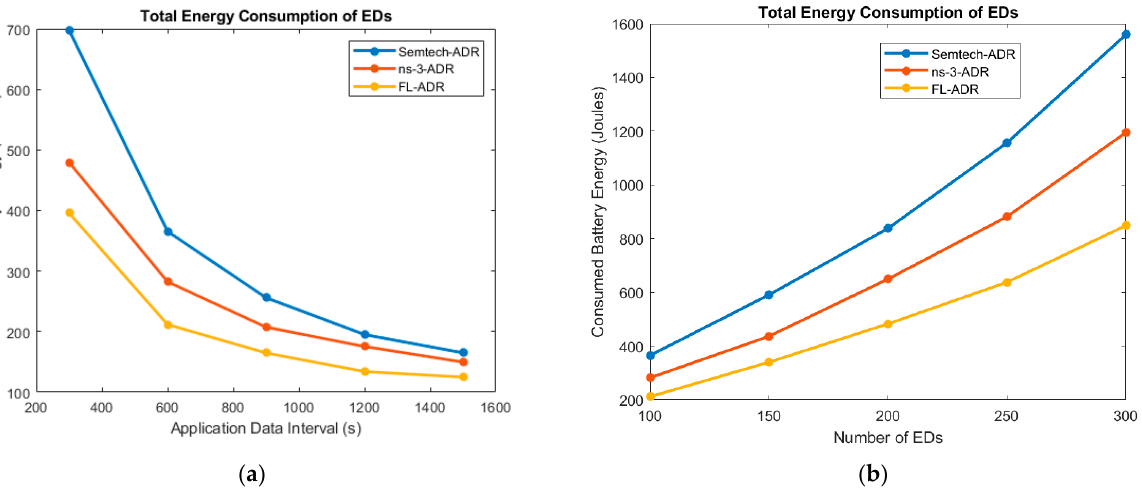
Figure 5. The total energy consumption: ( a ) data interval vs. total consumed energy; ( b ) no. EDs vs. total consumed